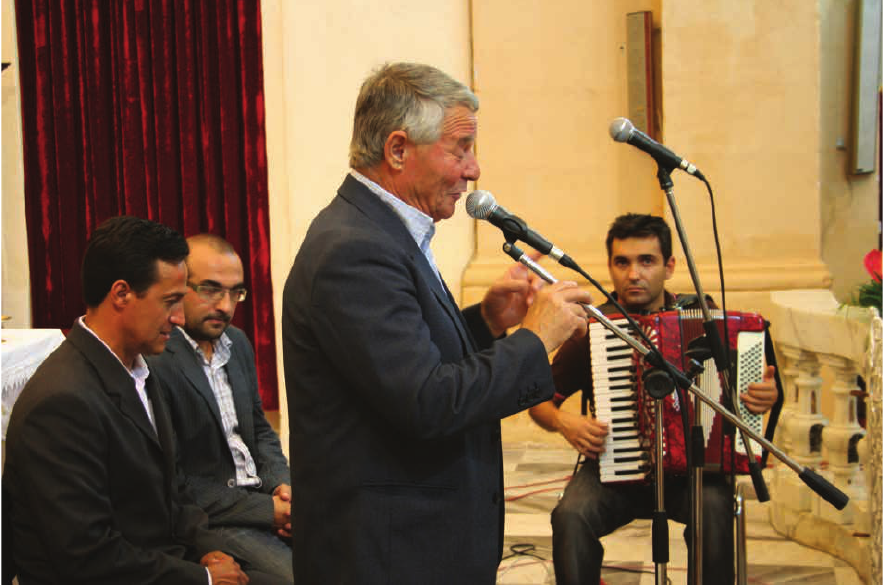
Figure 4: The performance held at Gonnosfanadiga, 3 September 2011 (photo by PB). The improvising poet Efisio Caddeo is singing, accompanied by Gianfranco Massa (accordion). Giuseppe Caddeu (seated, left) and Alberto Atzori (seated, right) are planning while waiting for their